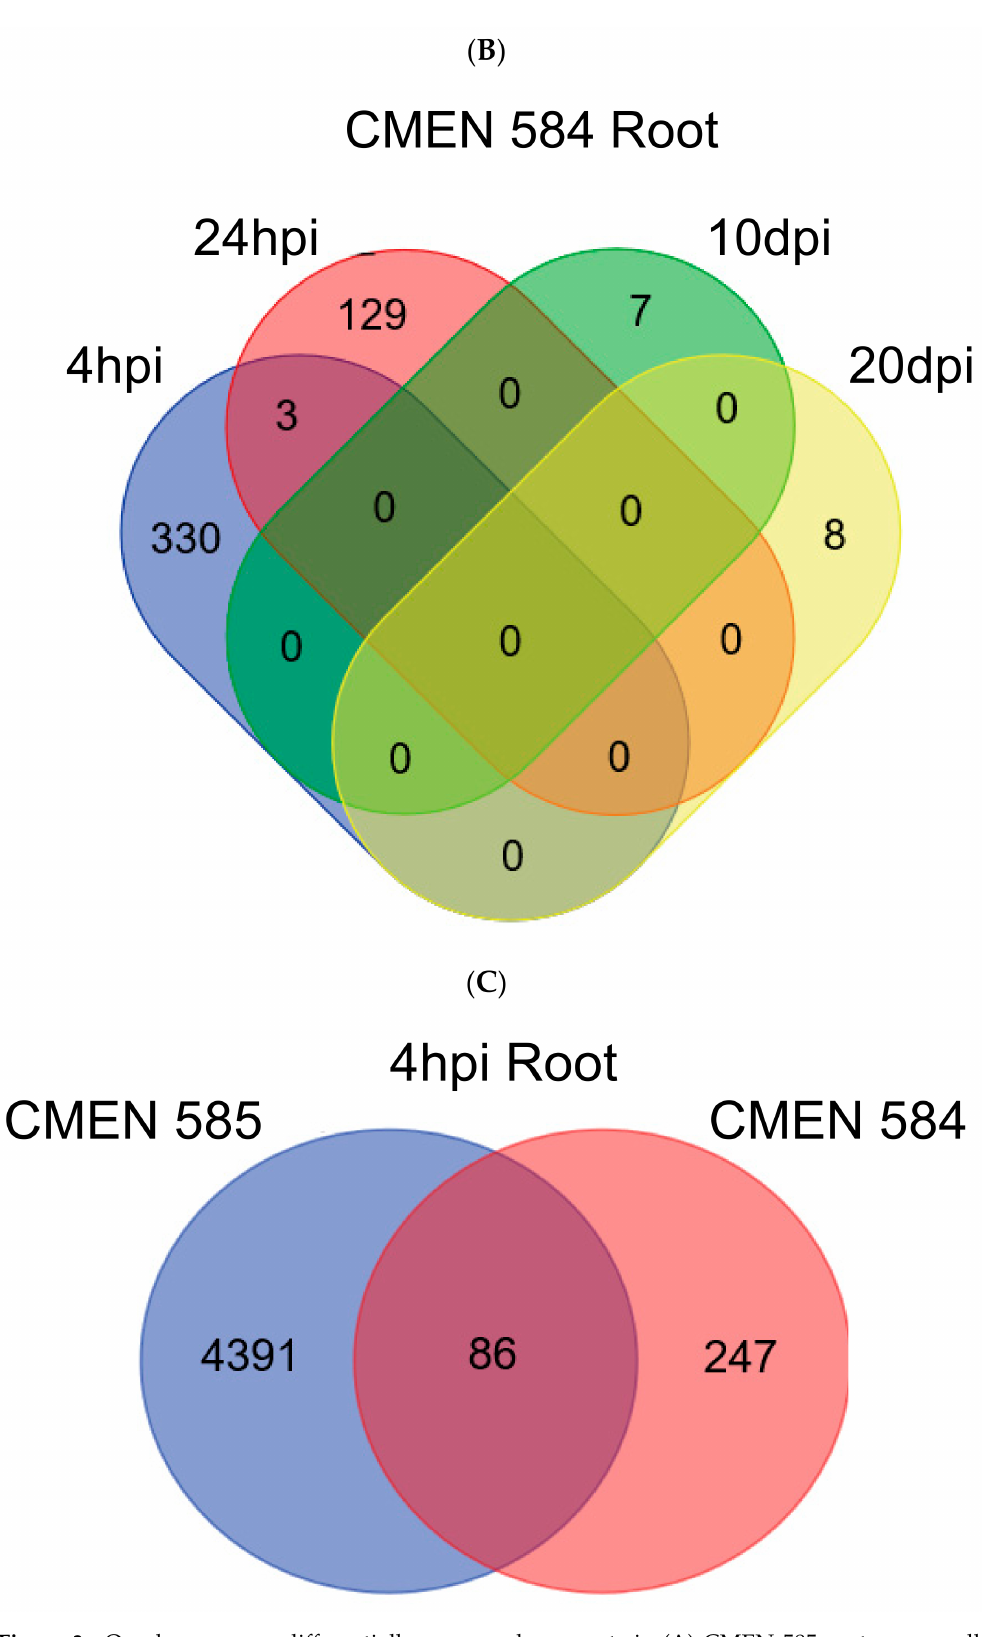
Figure 3. Overlaps among differentially-expressed gene sets in ( A ) CMEN 585 roots across all sampling times (hours post-inoculation (hpi), days post-inoculation (dpi)); ( B ) CMEN 584 roots across all sampling times; ( C ) CMEN 585 and CMEN 584 roots at four hours post-inoculation